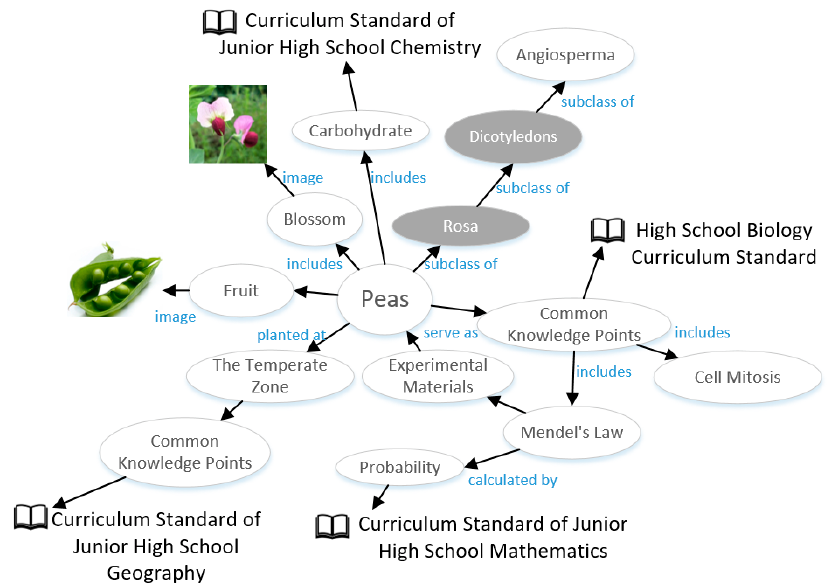
Figure 3. Interdisciplinary knowledge graph automatically generated based on keyword "peas"